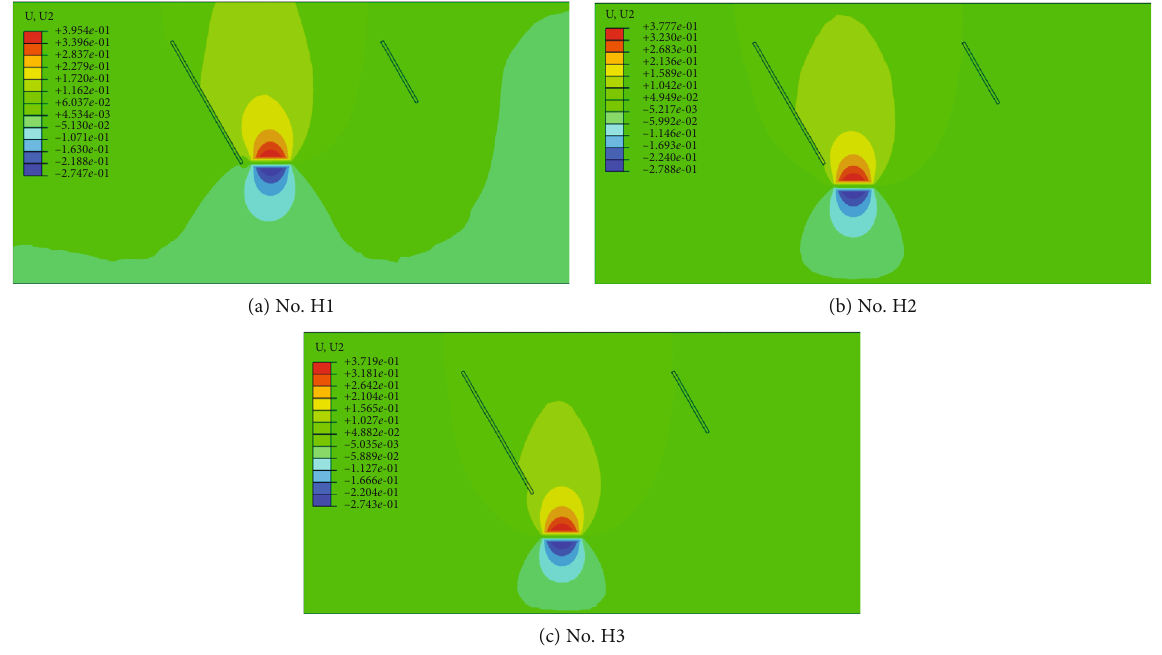
Figure 24: Distribution vertical displacement when the fracturing region is P1 (a), P2 (b), and P3 (c).